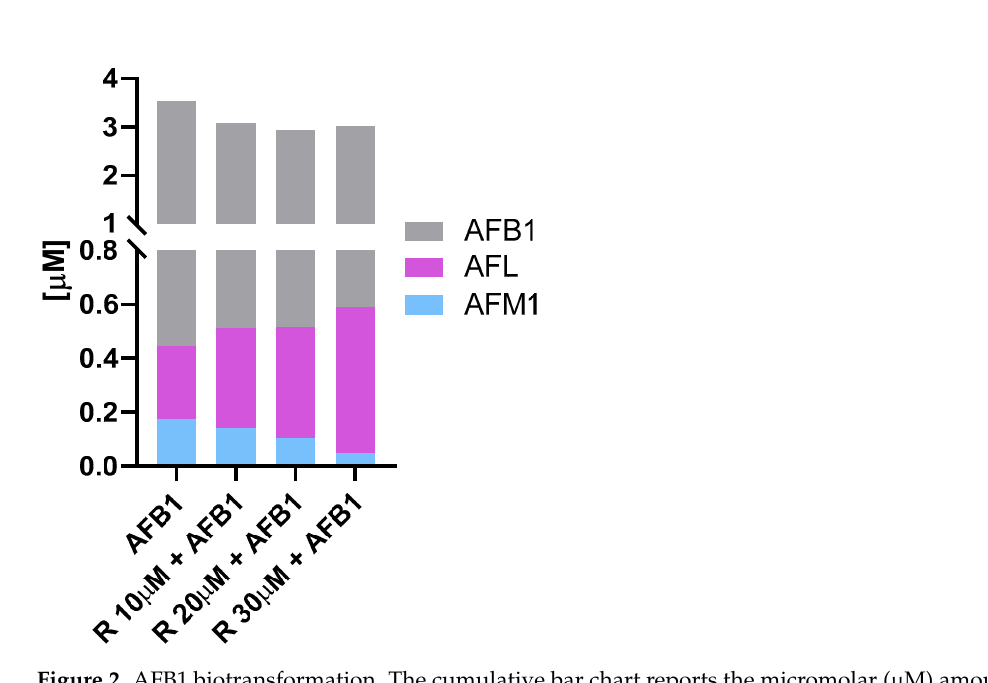
Figure 2. AFB1 biotransformation. The cumulative bar chart reports the micromolar ( µ M) amount of AFB1, AFM1, and AFL detected in the medium of BFH12 cells exposed to AFB1 alone or in combination with 10, 20, or 30 µ M of R. R = resveratrol.3.3. Target gene expression analysis.